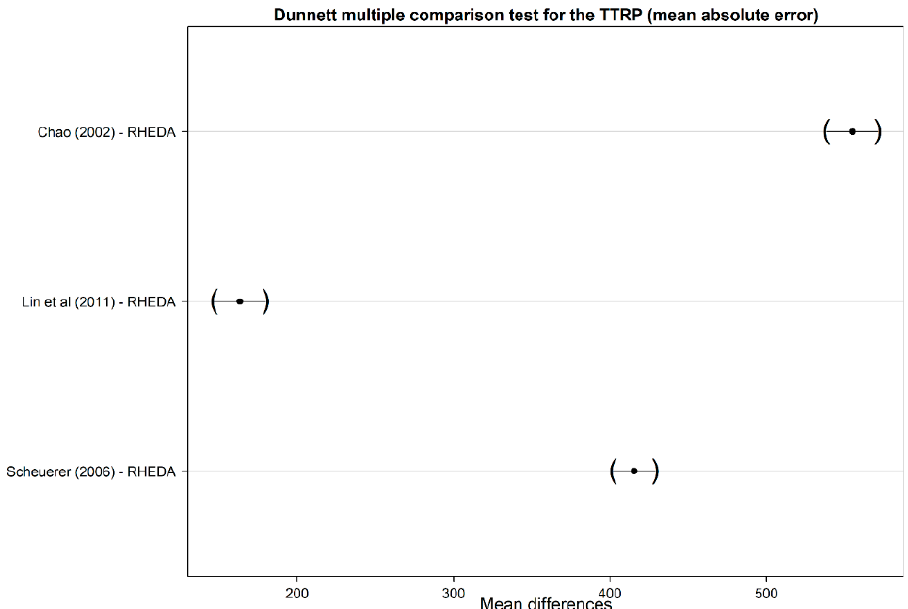
Figure 6. Dunnett test for the TTRP using the mean absolute error.